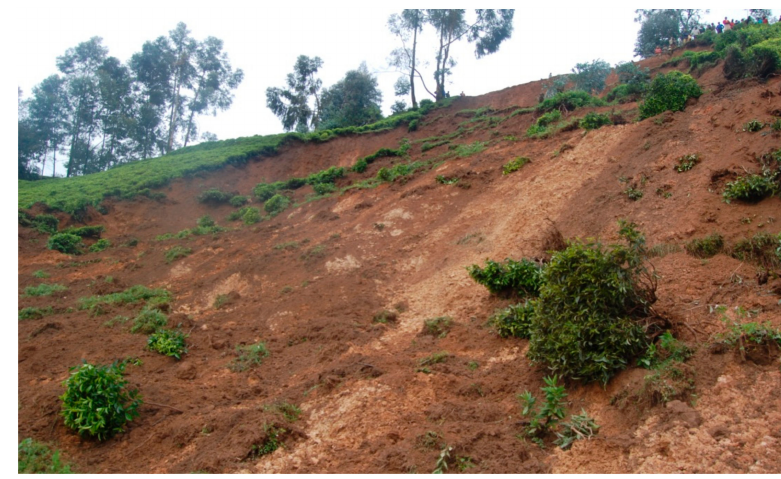
Figure 4. Areas affected by landslides in the study area (field visits to Rwanda, January–September 2017).